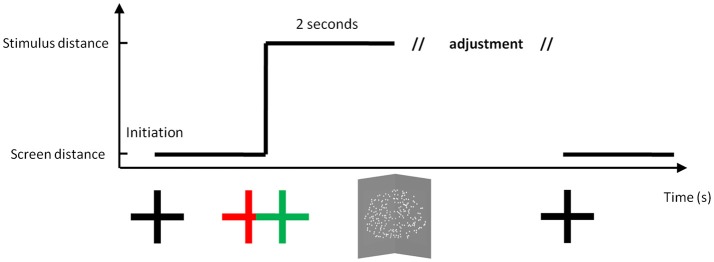
A typical trial. Before initiation, the fixation cross was located on the screen plane at a given distance (57, 80, and 133 cm). Following initiation by the participant, the fixation cross jumped in depth or remained in the same plane, and then stayed on the display for 2 s. The apex of the angle was then placed at one of three possible distances (57, 80, and 133 cm), while the screen plane was set at one of these three possible distances. After adjusting the hinge angle, the cross returned back to the screen plane. Drawing is not to scale.